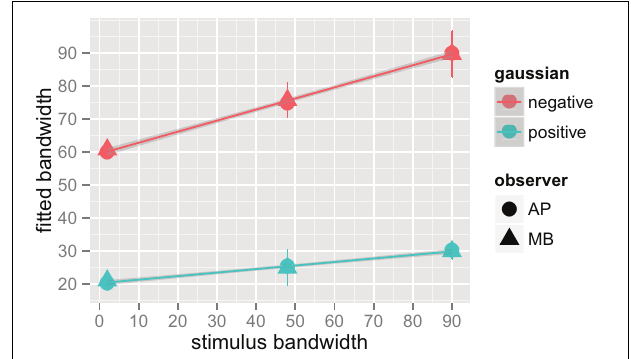
FIGURE 7 | Fitted difference of Gaussian bandwidth parameters for two observers, AP in circles and MB in triangles. The error bars are 95% confidence intervals on the fitted parameter obtained via the bootstrap. Blue symbols are for the positive, or central Gaussian, and the red symbols the negative or surround Gaussian. R was used to obtain a weighted least squares fit to the parameters as a function of bandwidth. Both increased by roughly 50% for both observers as bandwidth was increased from the narrowest stimulus bandwidth to the